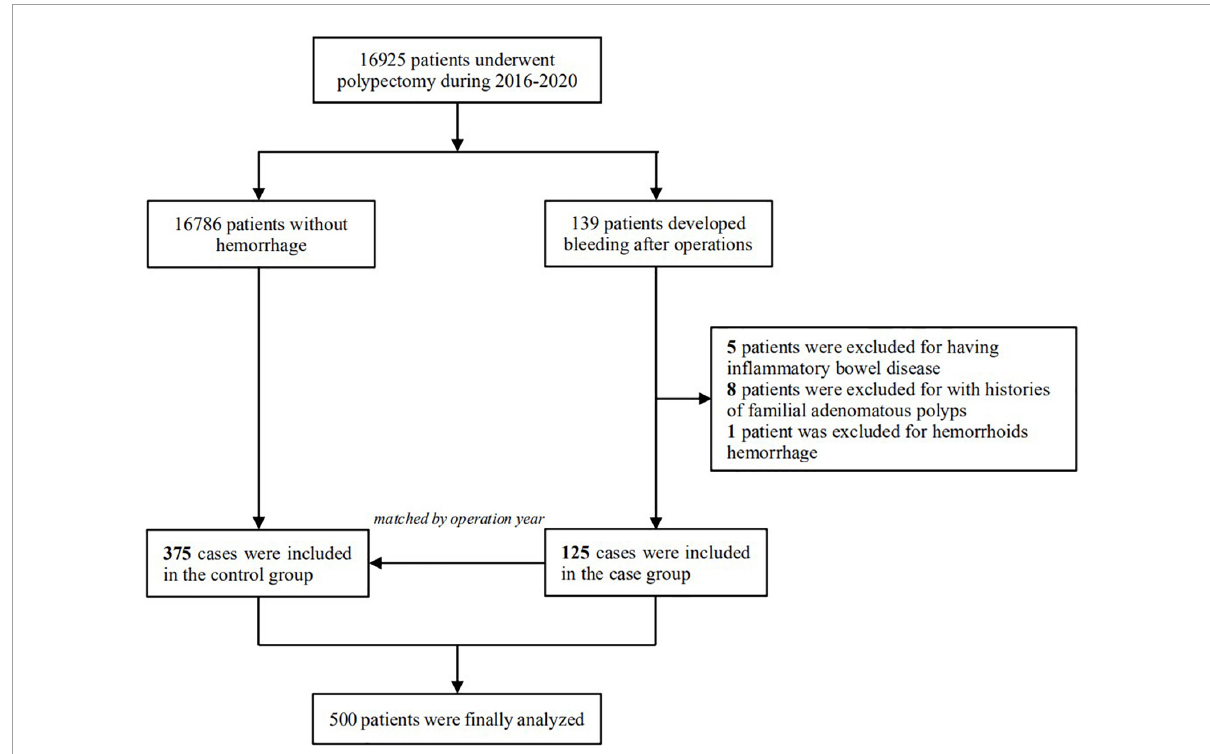
FIGURE1 Selection of the study population, 125 patients who developed delayed post-polypectomy bleeding and 375 patients randomly selected from the same cohort were finally included in the study.